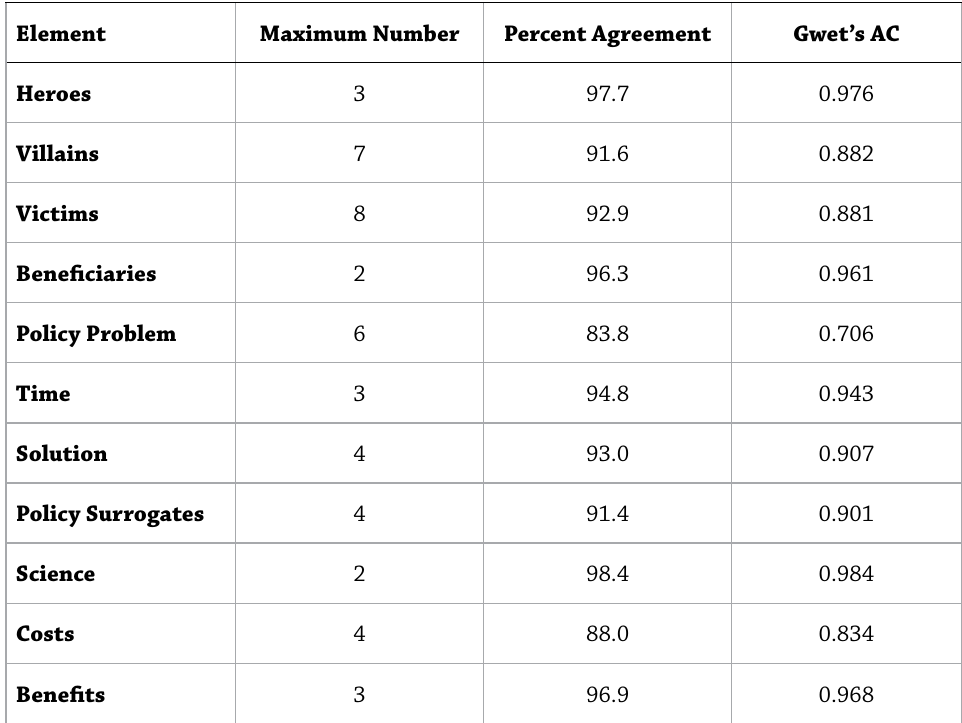
Table 3: Details on Coded Narrative